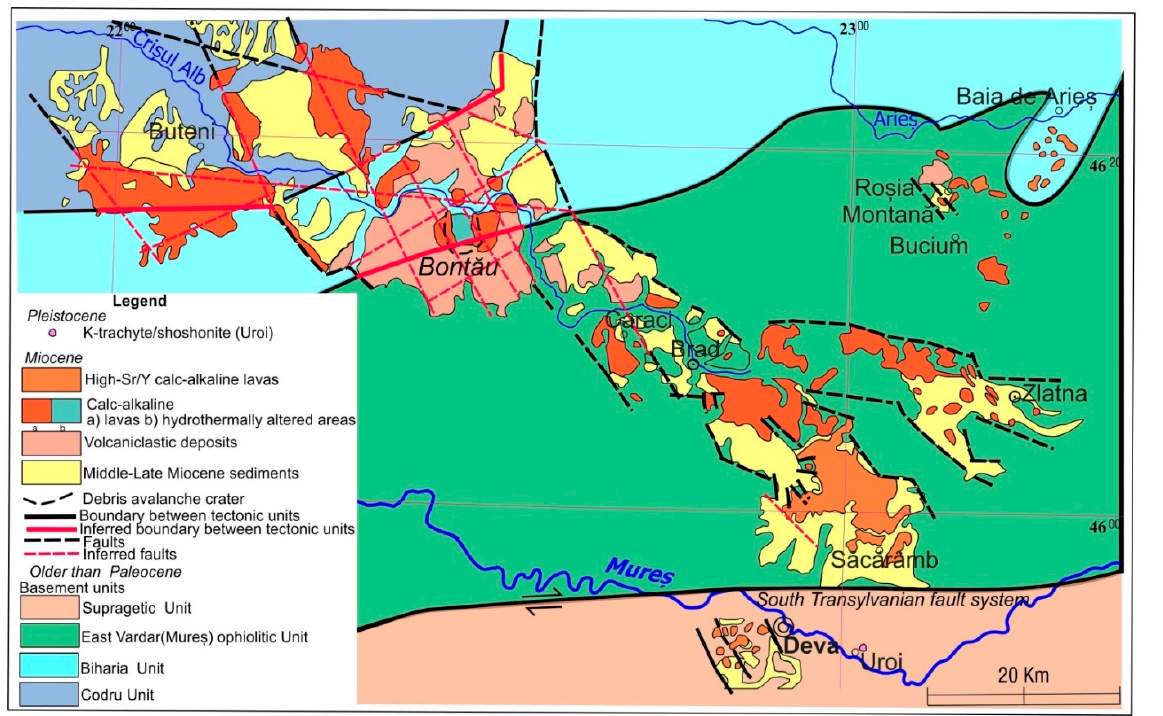
Figure 2. Sketch of Miocene magmatic rock occurrences in the NW-SE graben of the Z ă rand basin in the South Apuseni Mts. without Quaternary cover (after Geological map of Romania 1:1,000,000 and [3] with modifications). Bont ă u volcanic area is shown.